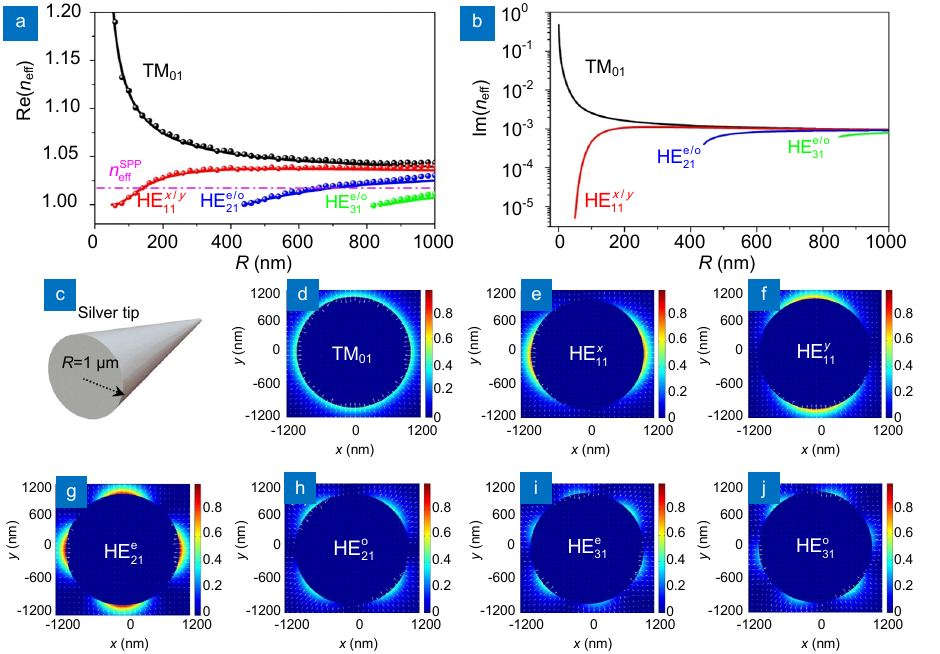
Fig. 3 | Effective indices n eff in real part ( a ) and imaginary part ( b ) of guided SPP modes versus the radius of cylindrical silver guide R . ( c ) Sketch map of a silver tip removing the diffracting grating. ( d – j ) Transverse modes intensity distributions of guided modes for R =1 μ